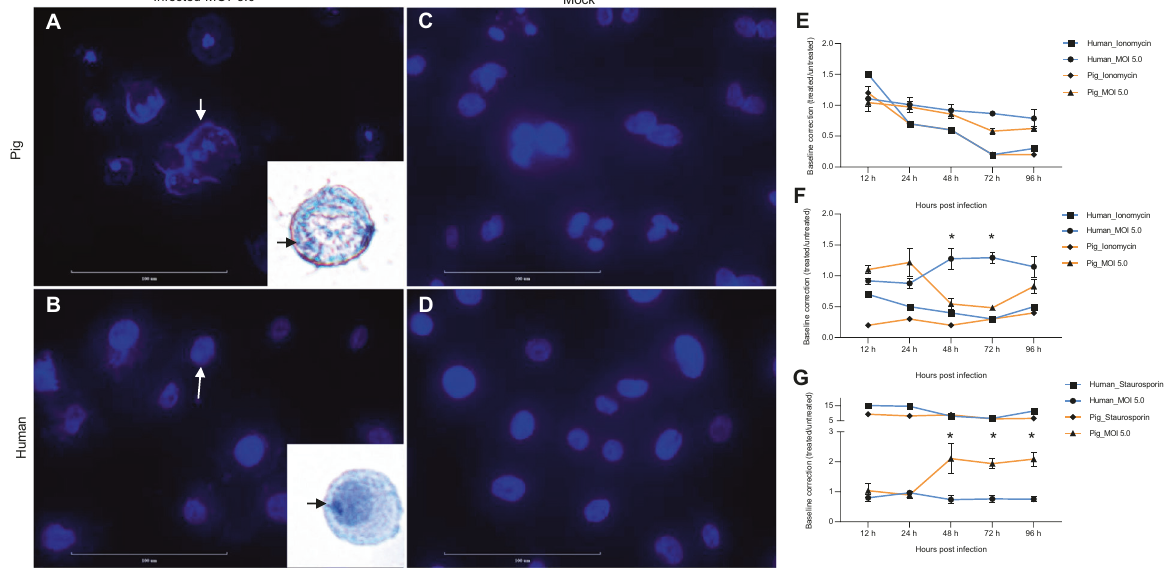
Fig. 4 SARS-CoV-2 associated cell death in HRECs and PRECs. A – D Representative images of 4% paraformaldehyde- fi xed cells stained with NucBlue fi xed cell ReadyProbes reagent (DAPI) showing cell nuclear morphology in A PRECs and B HRECs treated with SARS-CoV-2 (Isolate USA-WA1/2020) at MOI 5.0 for 9 h. Note the differences (arrows) in nuclear condensation and fragmentation (a hallmark of apoptosis) between human and porcine cells; inset images were stained with hematoxylin. C PRECs and D HRECs mock-inoculated cells; Scale bar-100 μ m; ( n = 6). E – G Line graphs (Mean; SD) were generated using ApoTox-Glo triplex assay data. The relative fl uorescence/luminescence units obtained from SARS-CoV-2 inoculated (treated) samples were normalized against their respective mock-inoculated control (culture medium) at each time point. Both HRECs and PRECs were inoculated with SARS-CoV-2 at MOI 5.0, 25 µM of ionomycin, and 0.625 µM of staurosporine for 12, 24, 48, 72, and 96 hpi. E Viability assay measuring live-cell protease activity, F Cytotoxicity assay measuring dead-cell protease activity, G Apotox assay measuring cleaved Caspase-3/7; ( n = 3). * p -value <